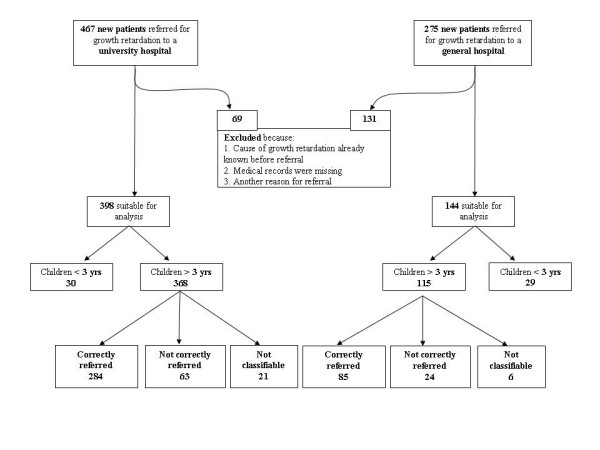
Population description.